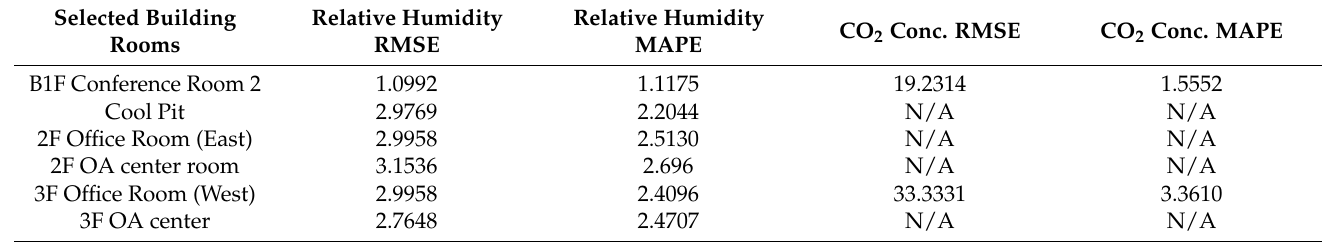
Table 3. Performance evaluation metrics results for relative humidity and CO 2 concentration.